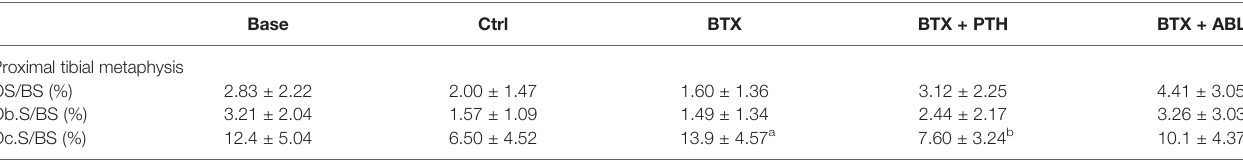
TABLE 6 | Osteoblast surface and osteoclast surface at the proximal tibial metaphysis of rats with the right hindlimb immobilized with BTX and treated with PTH or ABL. Base Ctrl BTX BTX + PTH BTX + ABL Proximal tibial metaphysis OS/BS